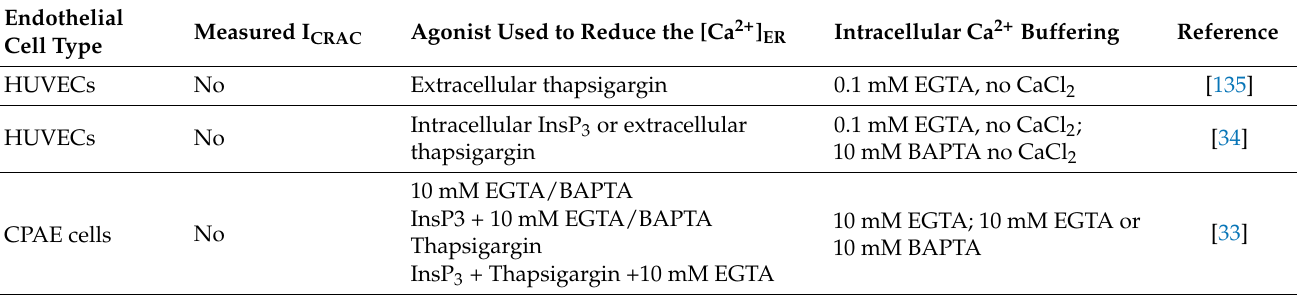
Table 1. Unsuccessful attempts to measure the endothelial I CRAC